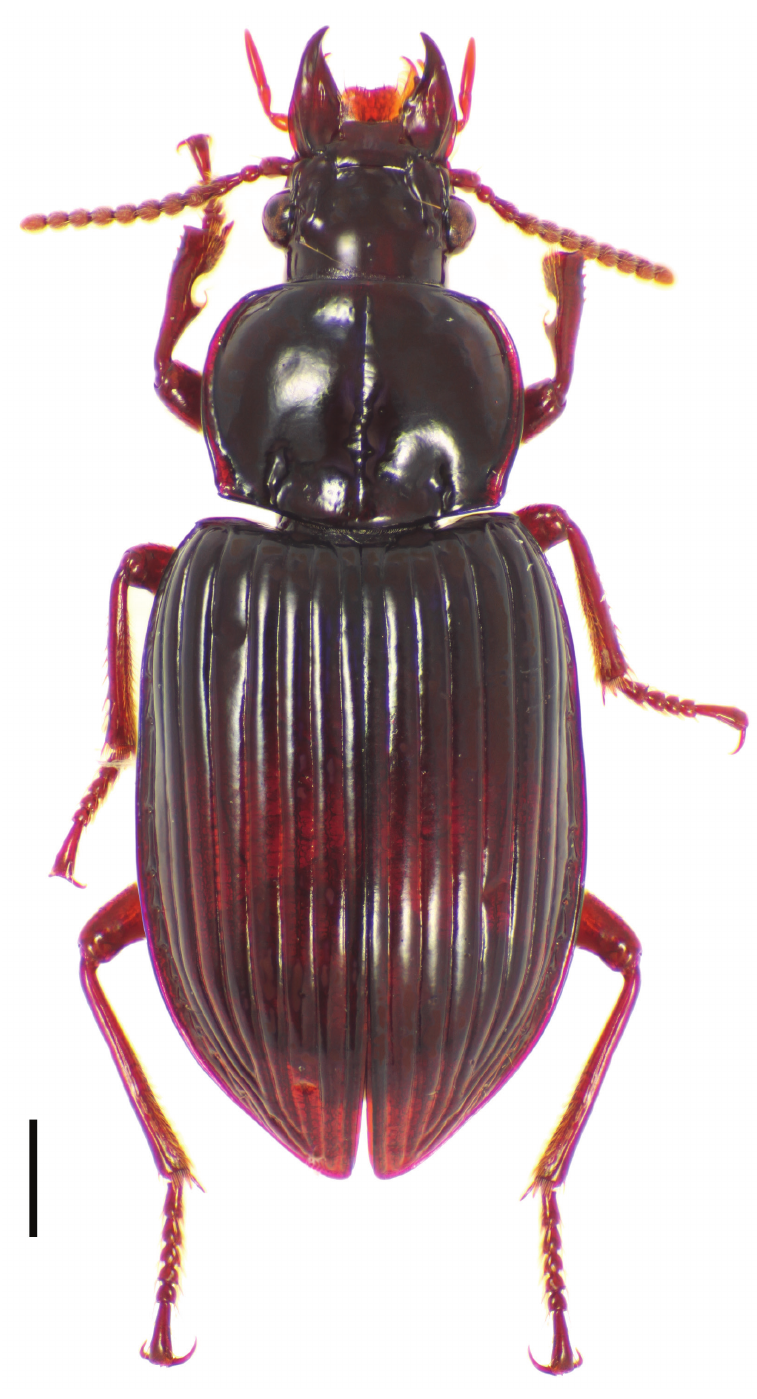
Figure 1. Dorsal habitus image of Cratocerus monilicornis Dejean. Scale bar =